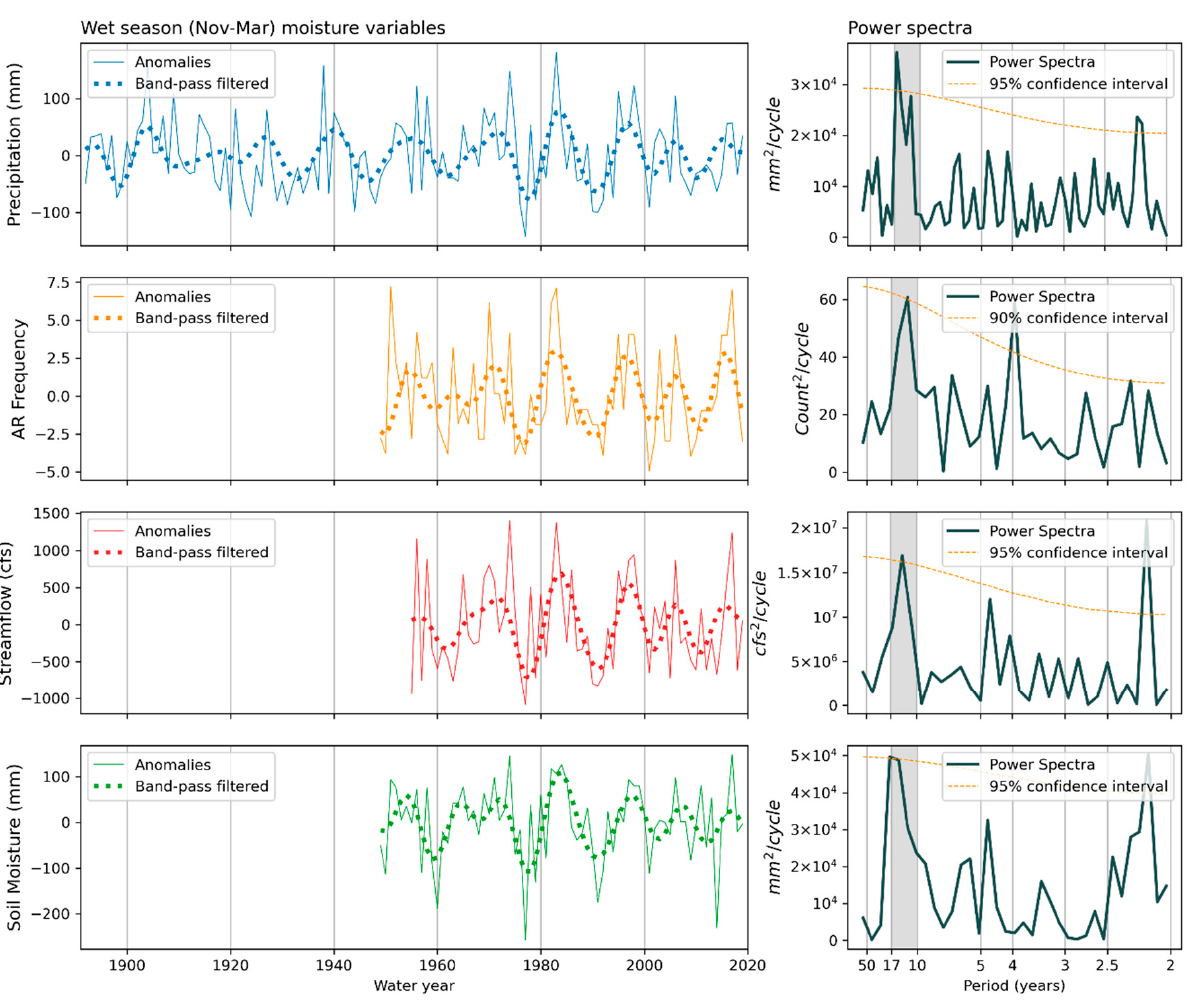
Figure 3. Linearly detrended and band-pass filtered (8–20 years) precipitation, AR frequency, streamflow and soil moisture for the ET-CA (left). Power spectra of respective ET-CA moisture variables, with the grey rectangle indicating the spectral peak of a 11- to 17-year cycle in each moisture variable (right). The dotted orange and red lines represent the 95% and 90% confidence intervals from the power spectrum of a first order Markov process.